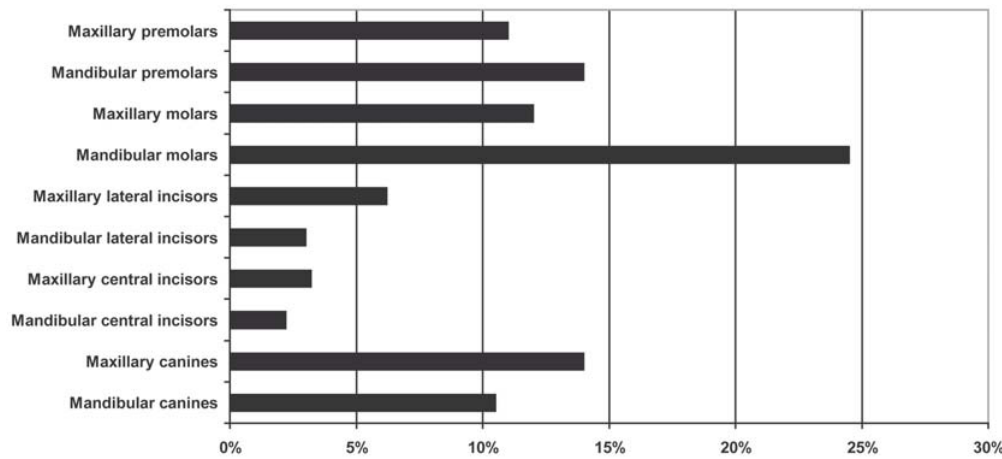
FIGURE 5- Histogram of the most affected groups of teeth in the permanent dentition